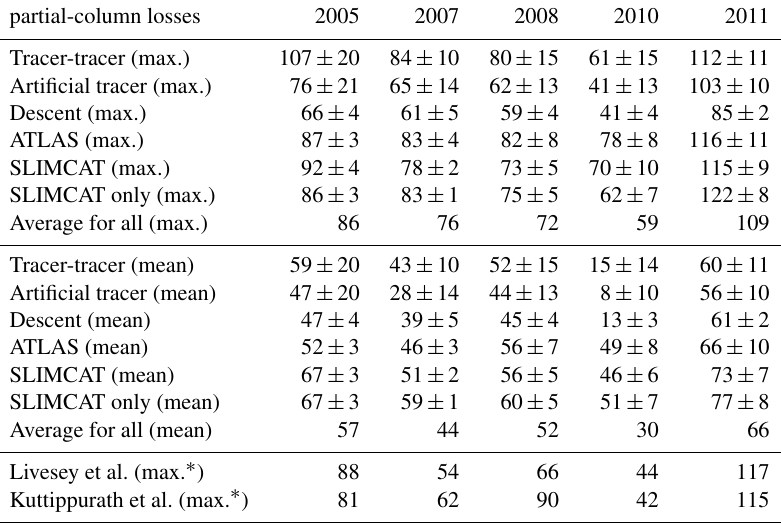
Table 1. Maximum and mean partial-column ozone loss estimate (in DU) between 380–550K from various methods (see details in the text), for March 2005, 2007, 2008, 2010, and 2011. The ± 1 σ uncertainties are stated, and the derivation is described in the text. These results are compared to previous quantifications of the integrated ozone loss (3500–550K) between 1 January and 1 April using the Aura MLS dataset by Livesey et al. (2015) and Kuttippurath et al. (2010,